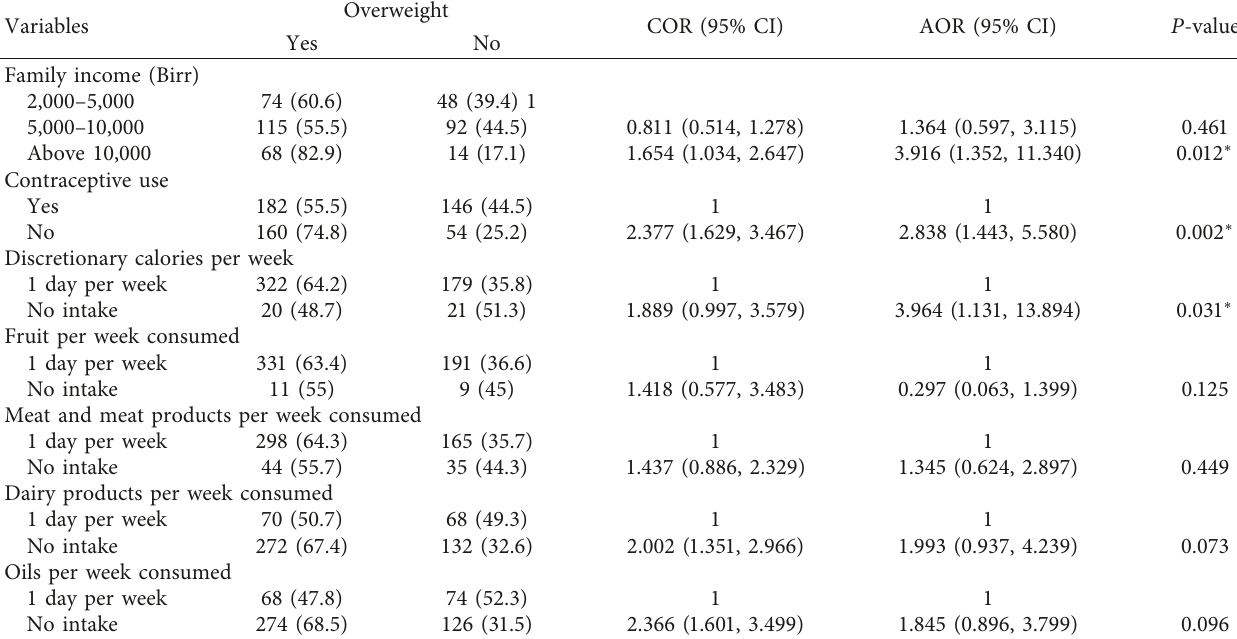
Table 4: Factors associated with overweight among the reproductive age group in Dire Dawa, 2021 ( n � 542).